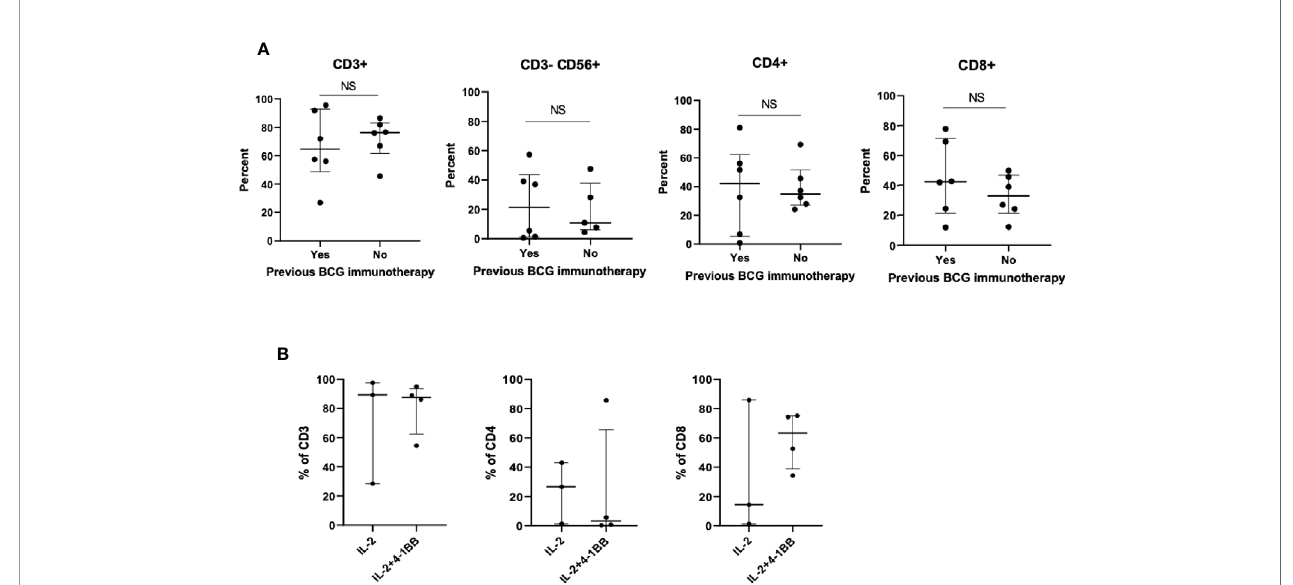
FIGURE 4 | Phenotype of TIL expanded from primary bladder tumors previously treated with BCG immunotherapy. (A) Six BCG-treated patients whose primary bladder tumors yielded TIL were matched with six BCG-untreated patients (1:1) in terms of patient age, tumor histology, tumor stage and molecular subtype of bladder cancer. At 4 weeks after the initiation of TIL cultures, TIL were collected from each fragment and the percentage of CD3+ T cells, CD4+ T cells, CD8+ T cells, and CD3-CD56+ NK cells was measured by fl ow cytometry. Each point represents the mean percentage of cells per patient (the mean of all TIL that was generated from each fragment within an individual patient). Wilcoxon-signed rank test. (B) Tumor fragments of three primary tumors previously treated with BCG immunotherapy were cultured either in IL-2 (6000 IU/ml) + 4-1BB (10 ug/ml) or in only IL-2 (6000 IU/ml). Percentage of CD3+ T cells, CD4+ T cells, and CD8+ T cells was measured by fl ow cytometry. Each point represents the percentage of cells generated from each tumor fragment. Median and interquartile